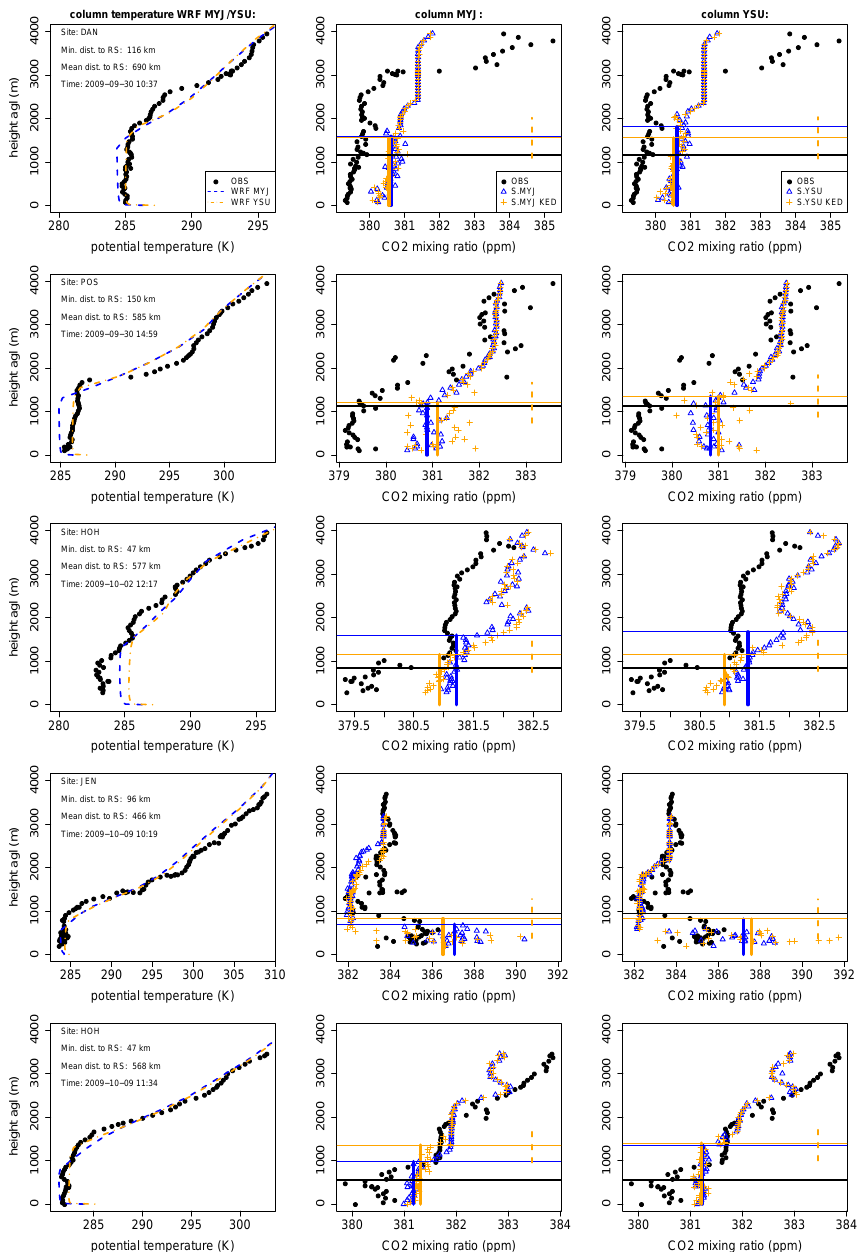
Figure 6. Measured and simulated IMECC profiles measured in daytime with enhanced mixing. The left column shows observed (black dots) and WRF simulated potential temperature. Shown are both WRF simulations using the YSU PBL (orange dash-dotted lines) and the MYJ PBL (blue dashed lines) parameterization schemes. The statistics in the temperature plots indicate the location and time of the profile. Site abbreviations correspond to the red squares on the map in Fig. 1. Also shown are the minimum and average distances to the next IGRA radiosonde used for optimization. The comparisons of STILT simulated and observed CO 2 profiles are shown in the middle and right columns. A new STILT receptor was defined every 10km horizontal or every 100m altitude change of the airplane. Horizontal lines indicate MHs. Observed MHs were derived by analysing gradients in the CO 2 profile (see text for details, black lines). STILT MHs are averages from all receptors of a given profile. STILT CO 2 profiles are shown with (orange crosses) and without optimized MHs (blue triangles). One standard deviation of the KED error is shown as an orange dotted bar in the right of each plot. Thick vertical lines from the surface (0ma . g . l . ) to each MH correspond to mixing layer averaged CO 2 (blue and orange